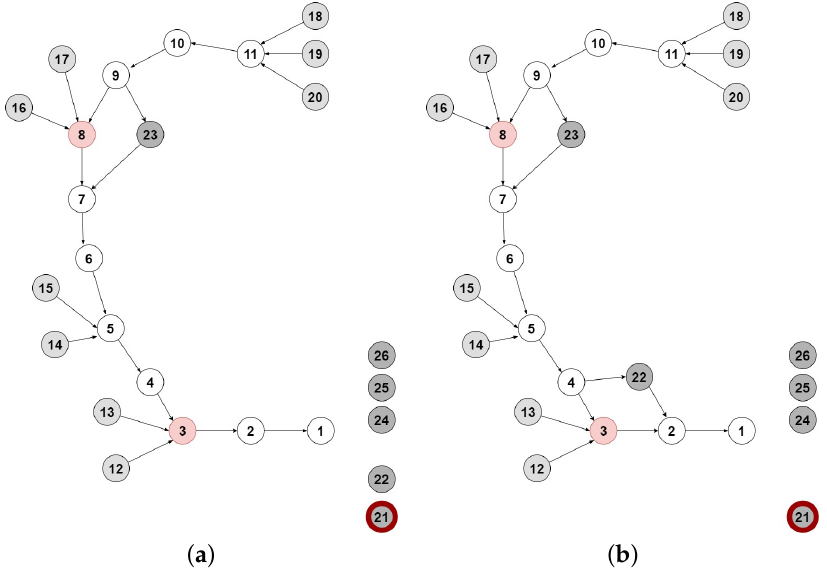
Figure 8. Scenarios of returning back. ( a ) Returning Scenario (3A), ( b ) Replacement Scenario